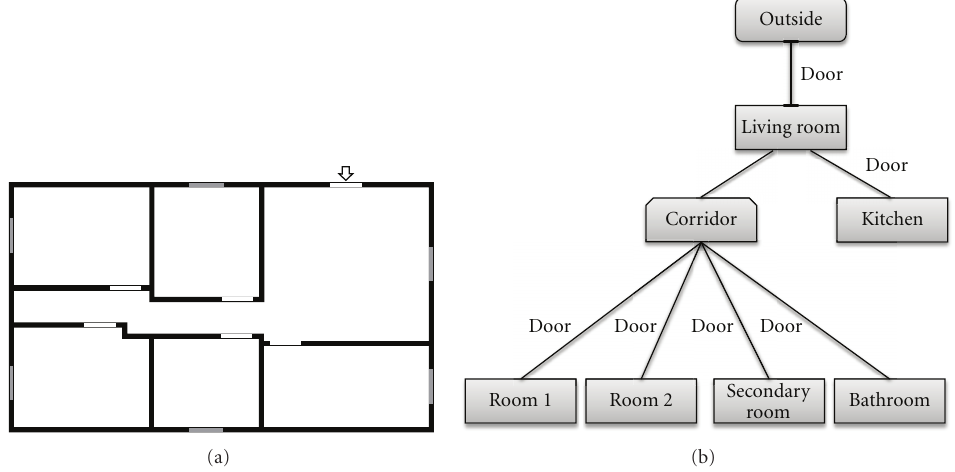
Figure 13: Example of floor plan of Figure 12 (a) containing corridors and all rooms are connected to the living room and its respective connectivity graph (b).